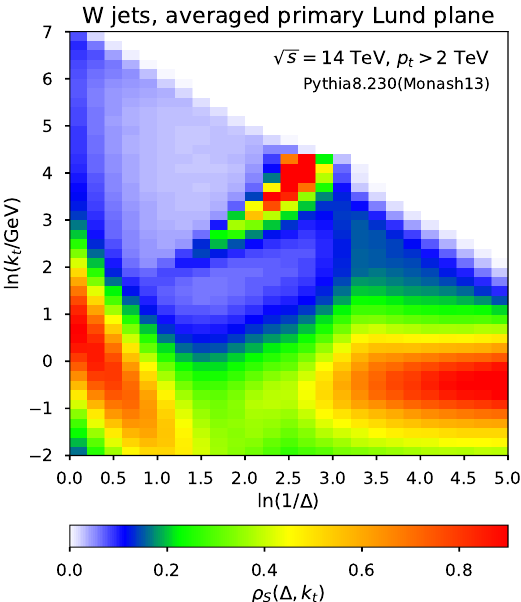
Figure 7. Lund-plane emission density, (cid:26) S ((cid:1) ; k t ), for hadronically decaying boosted W bosons, in WW events, using the same jet-clustering and selection as in (cid:12)gure